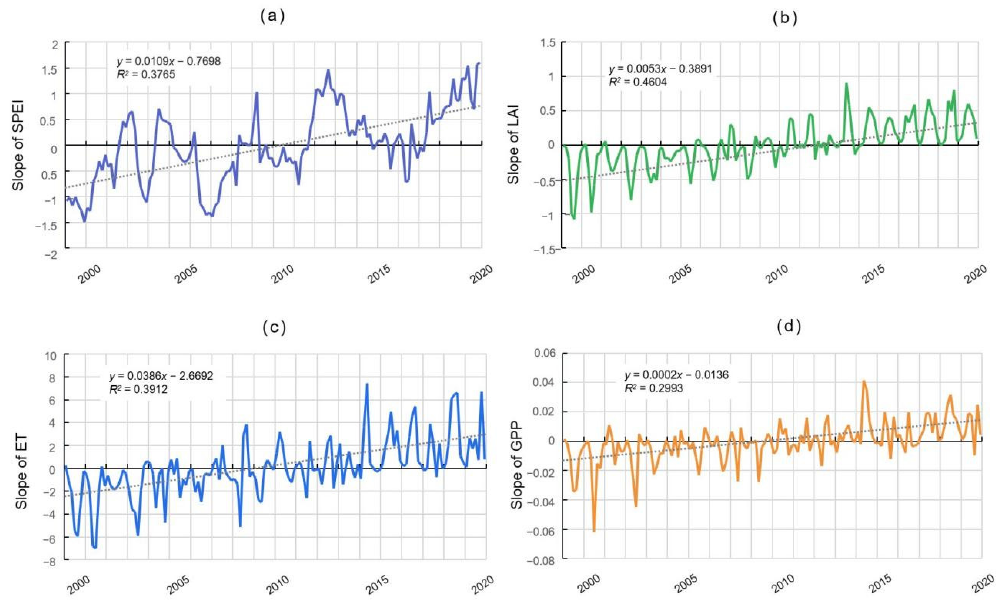
Remote Sens. 2022 , 14 , x FOR PEER REVIEW Figure 2. Trends of SPEI ( a ), LAI ( b ), ET ( c ), and GPP ( d ) from 2000 to 2020 ( p < 0.05). Table 1. Change trend types of four variables.